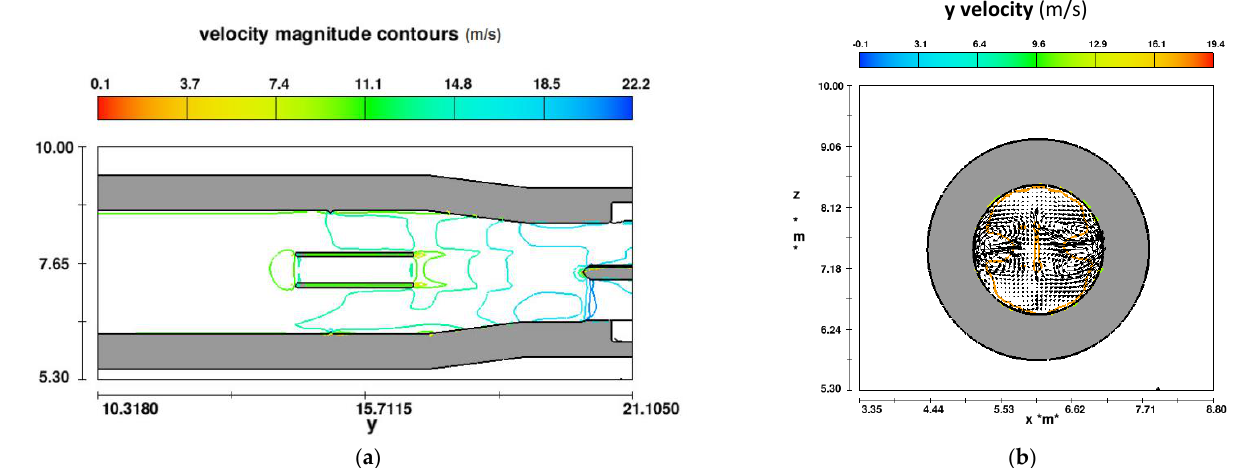
Figure 6. ( a ) sectional view of velocity magnitude contours for the longitudinal distance between two valves = 2D; and ( b ) cross-flow vector and contours of the stream-wise velocity component.